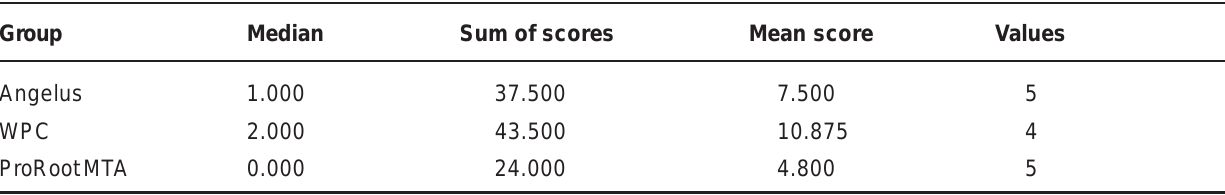
Hc= 5.265000 Exact probability = 0.063270 Chi-square at 2 degrees of freedom Probability = 0.071898 Study groups without statistical difference (p>0.05)